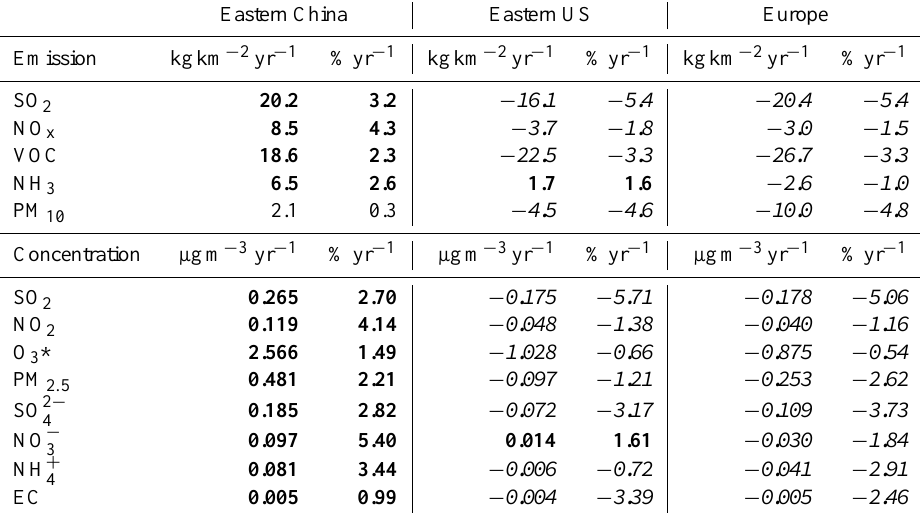
Table 3. Simulated trends in three regions